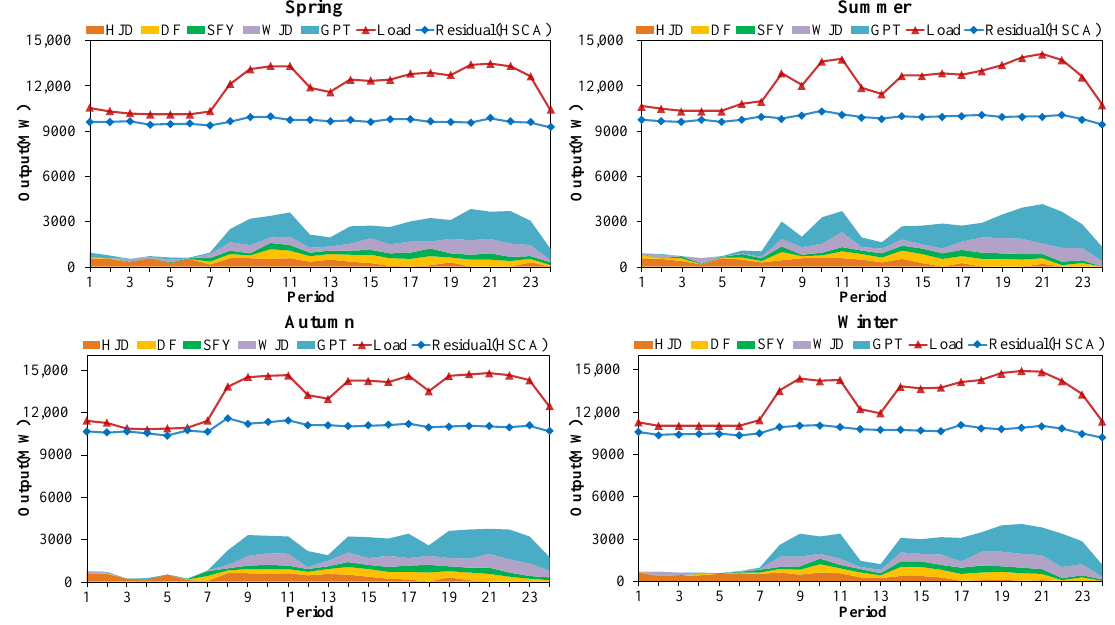
Figure 12. The output process obtained by HSCA in the real-world cascade hydropower system.